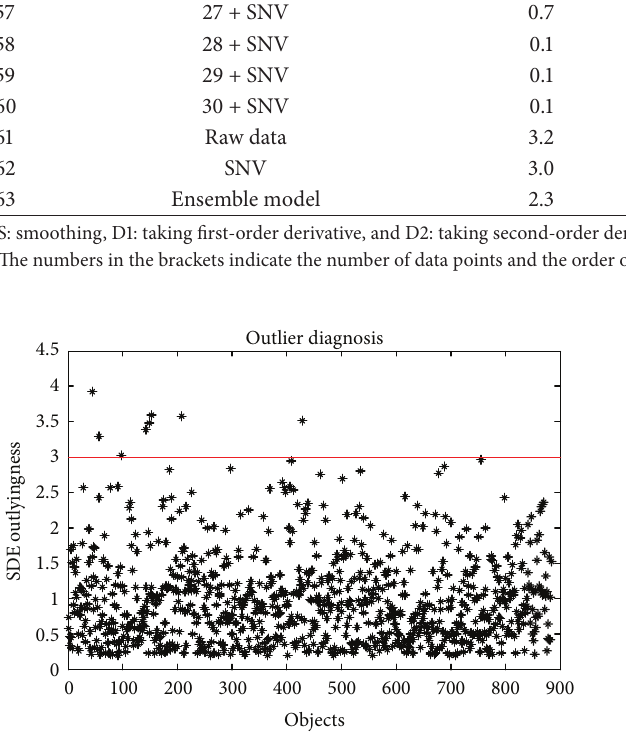
Figure 2: Stahel-Donoho estimates (SDE) of outlyingness values for 884 measured pidan objects based on raw NIR